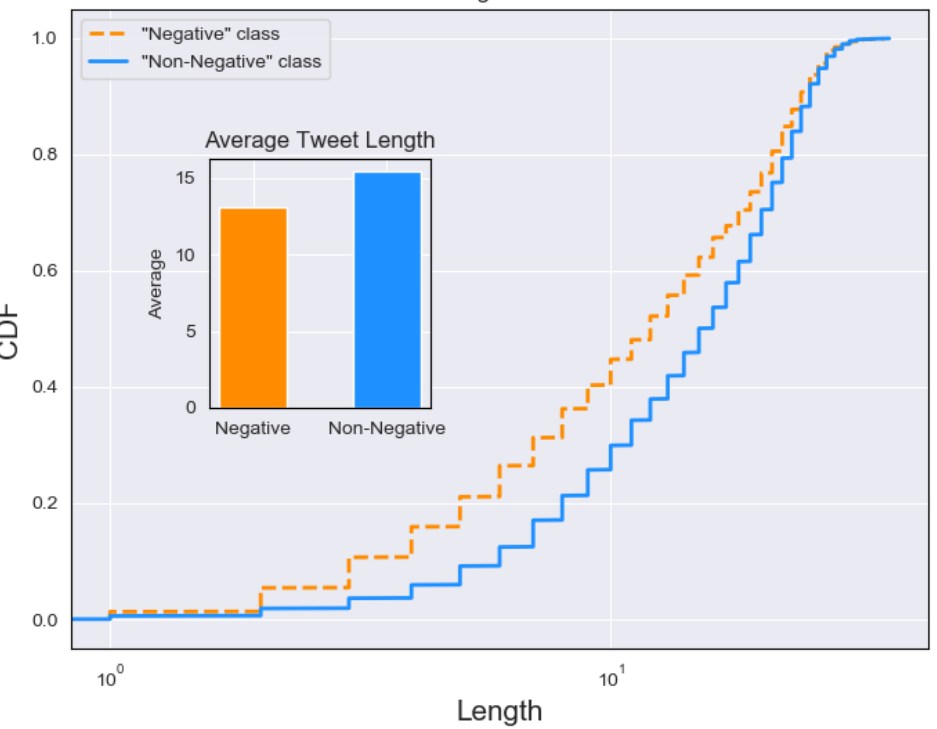
Figure 4. Averages (inner plot) and Cumulative Distribution Function of Tweet lengths for both